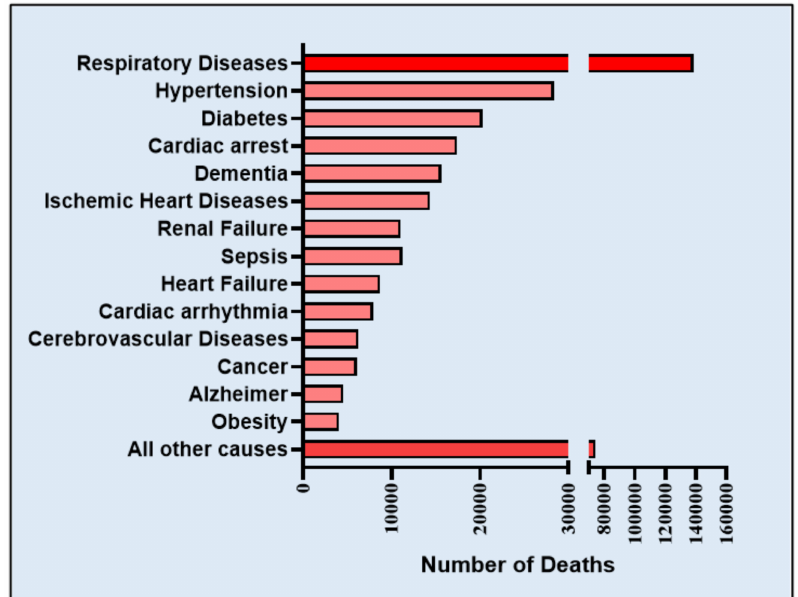
Figure 4. Conditions contributing to the deaths of COVID-19 patients in the United States of America (according to Death Data of CDC as of 25 July 2020). Deaths involving more than one condition (e.g., deaths involving both diabetes and respiratory arrest) were counted in both